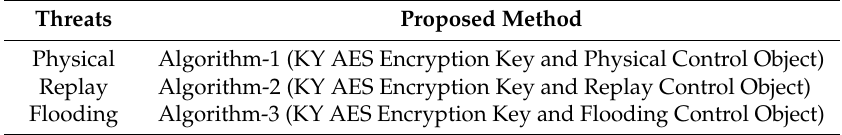
Table 1. Proposed alleviation methods used in the Security Improvement Framework (SIF).